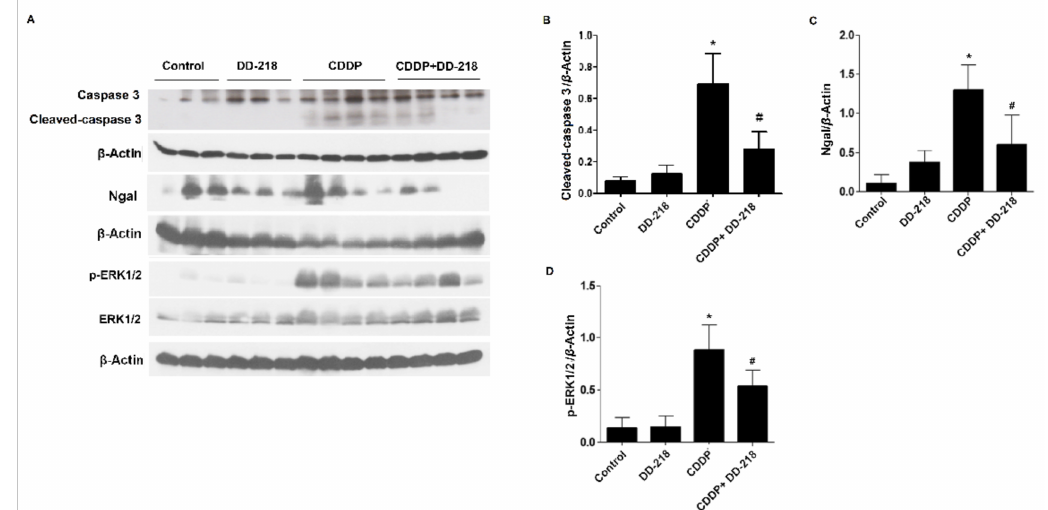
Figure 8. Protein expression of kidney injury markers. Representative blots ( A ) and quantitative renal expression of cleaved-caspase 3 ( B ), NGAL ( C ), and p-ERK1/2 ( D ). Mice were treated with saline for 72 h, n = 5; 50 mg/kg/day for 6 days of DD-218, n = 5; a single dose of 20 mg/kg of CDDP, n = 6; co-treatment with 50 mg/kg/day for 3 days of DD-218 followed by a single dose of 20 mg/kg of CDDP, n = 7. Values are expressed as means ± SD: * p < 0.05 compared to control; # p < 0.05 compared to CDDP